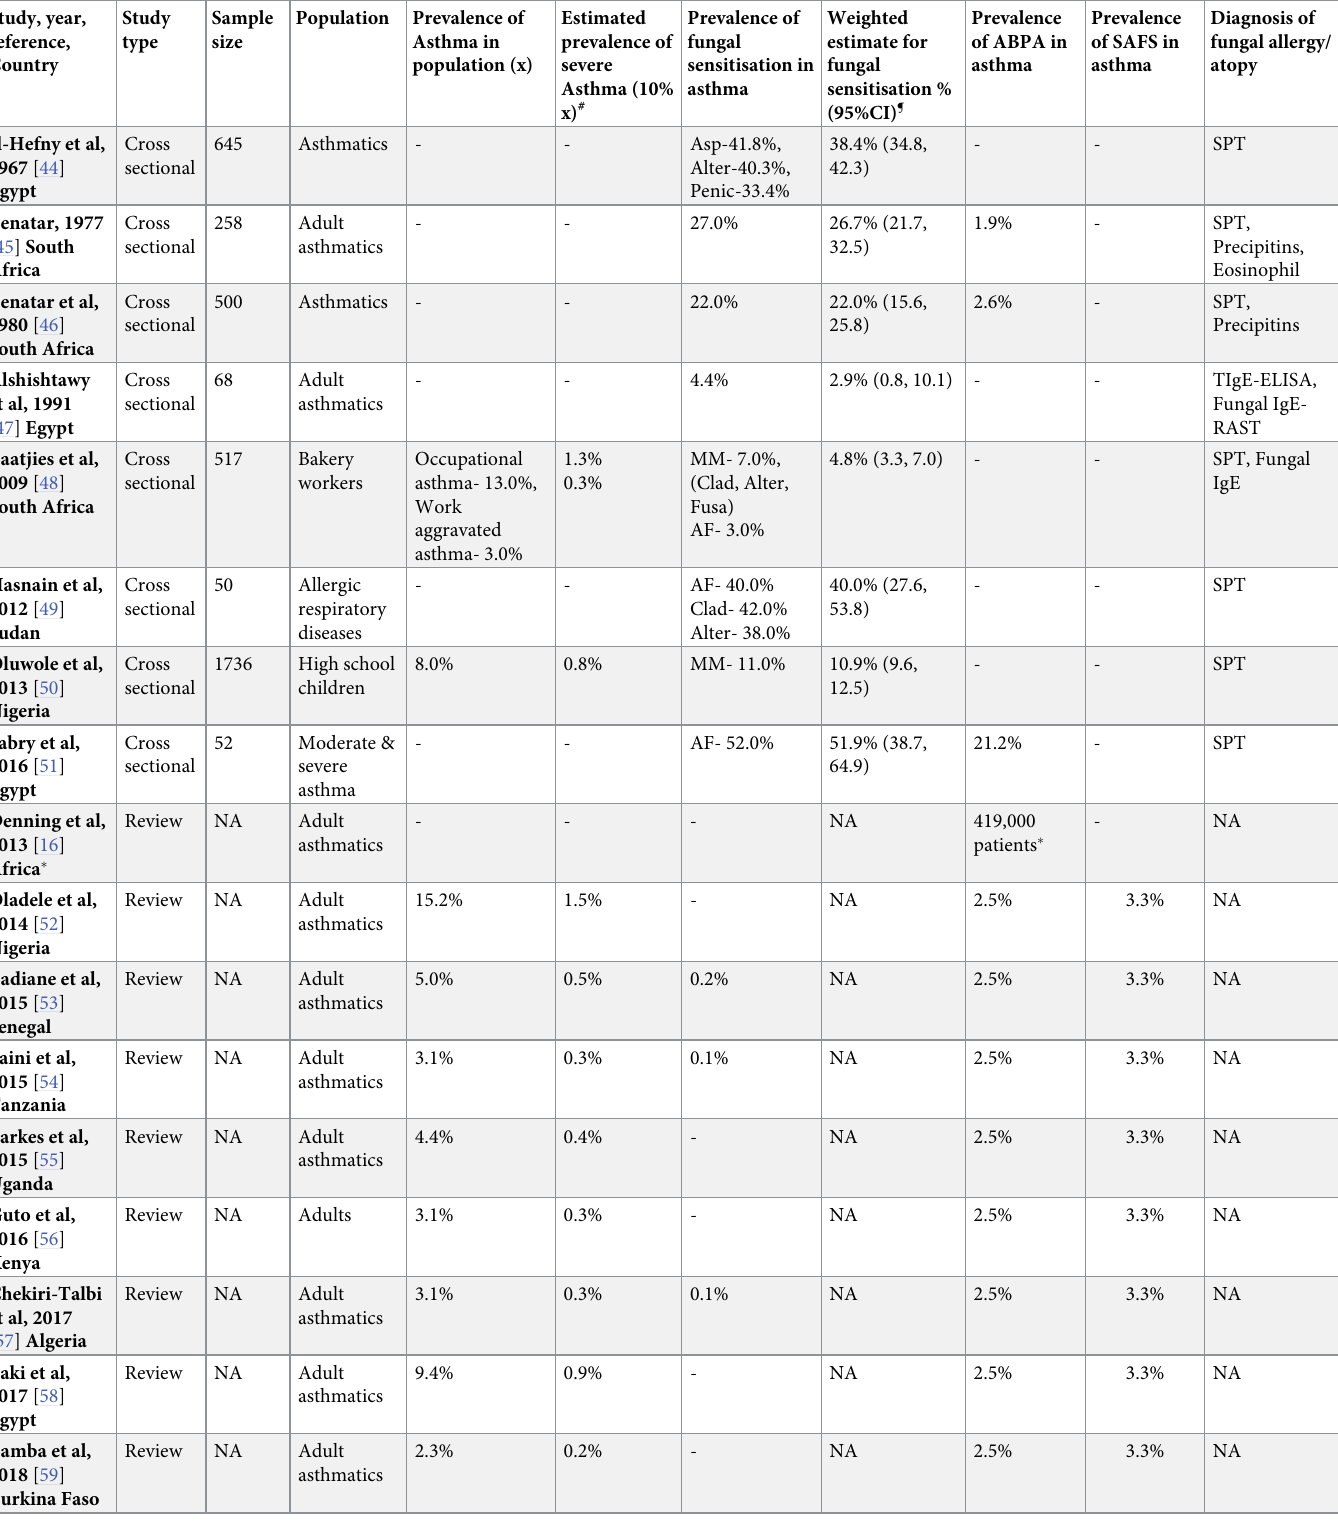
Table 1. Studies describing the burden of fungal asthma in Africa. Study, year,